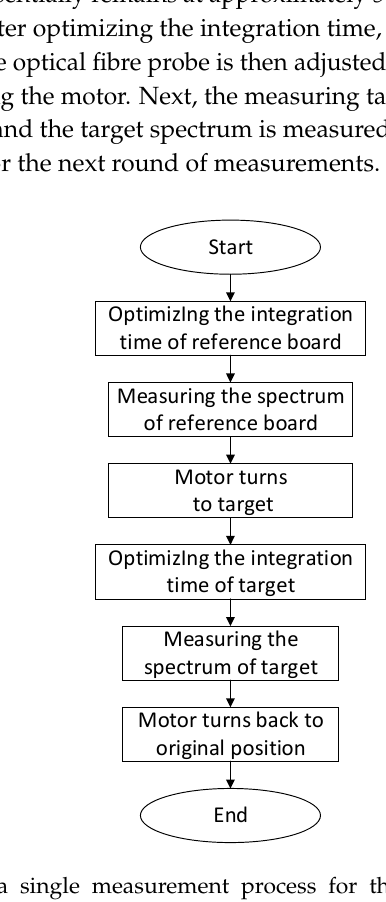
Figure 2. Flowchart of a single measurement process for the vegetation canopy continuous observation